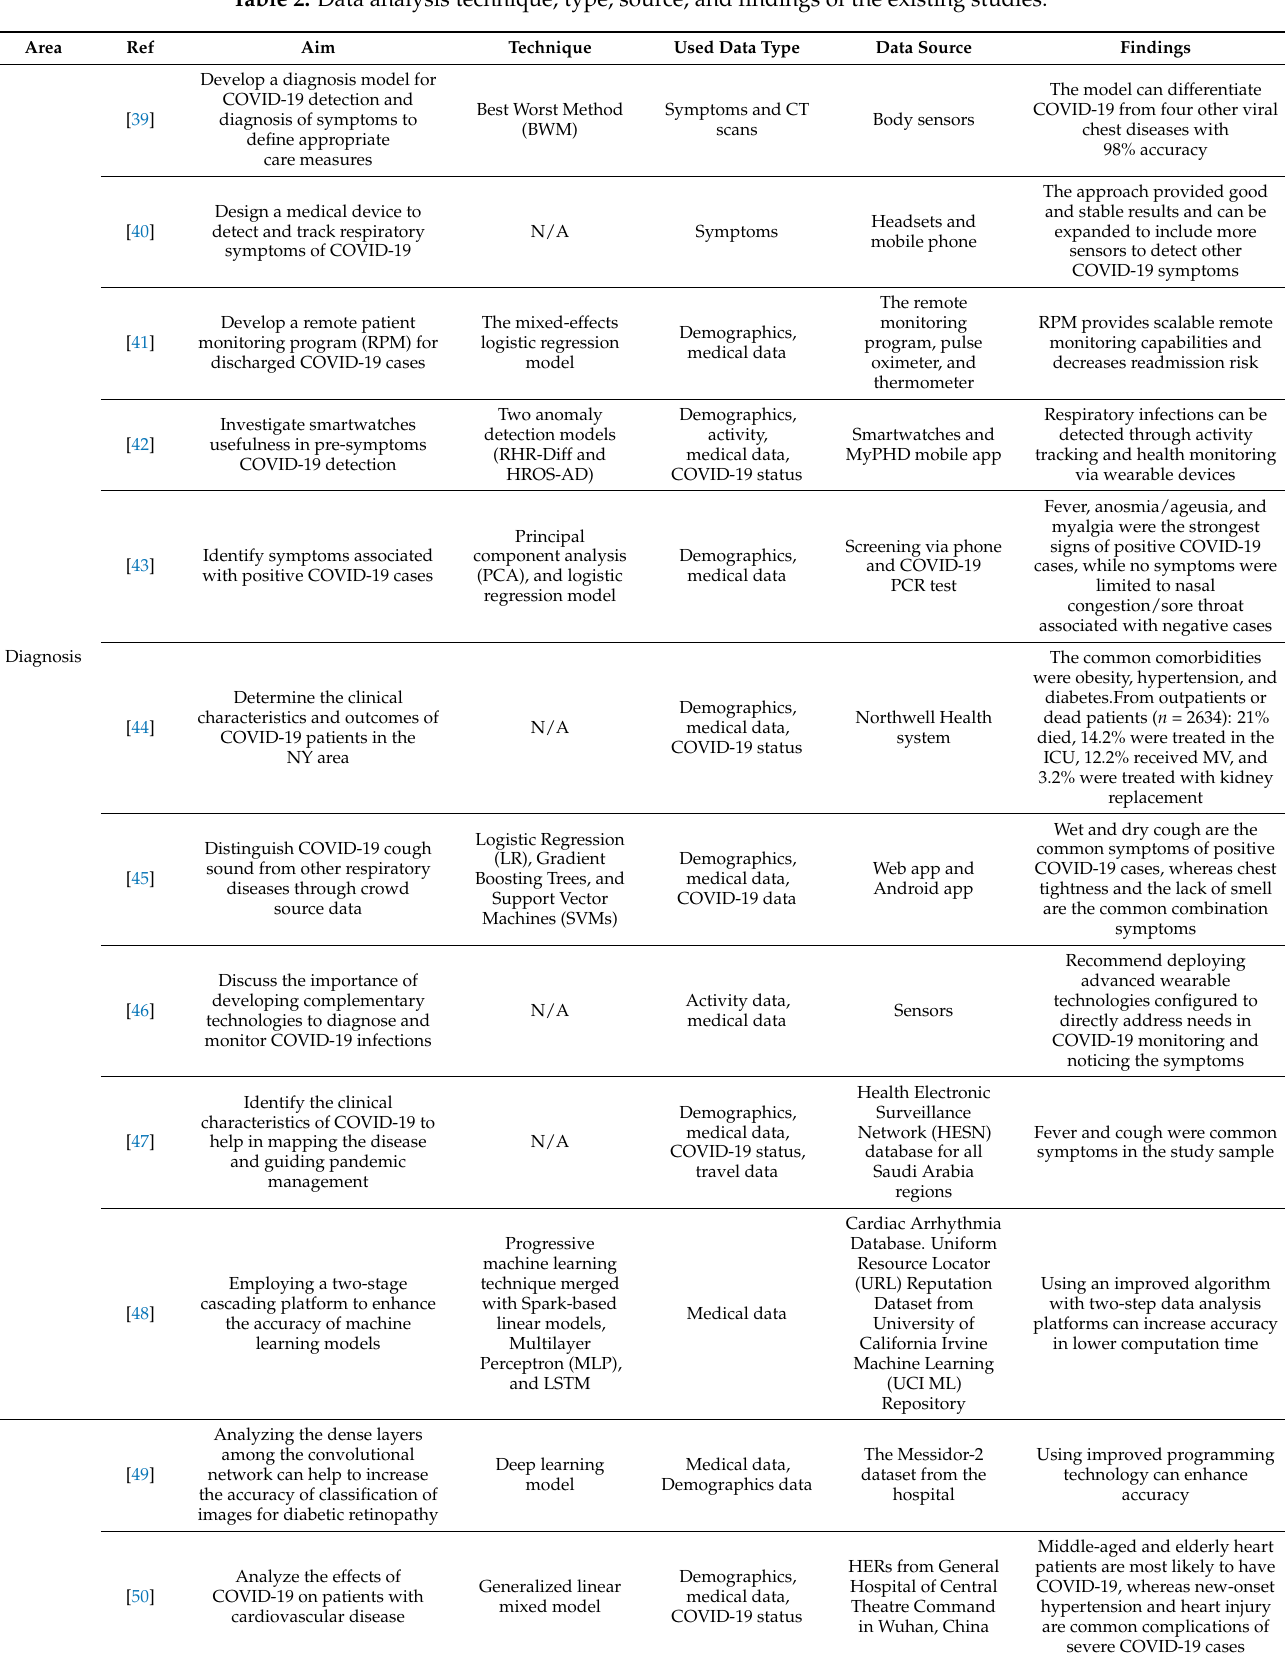
Table 2. Data analysis technique, type, source, and findings of the existing